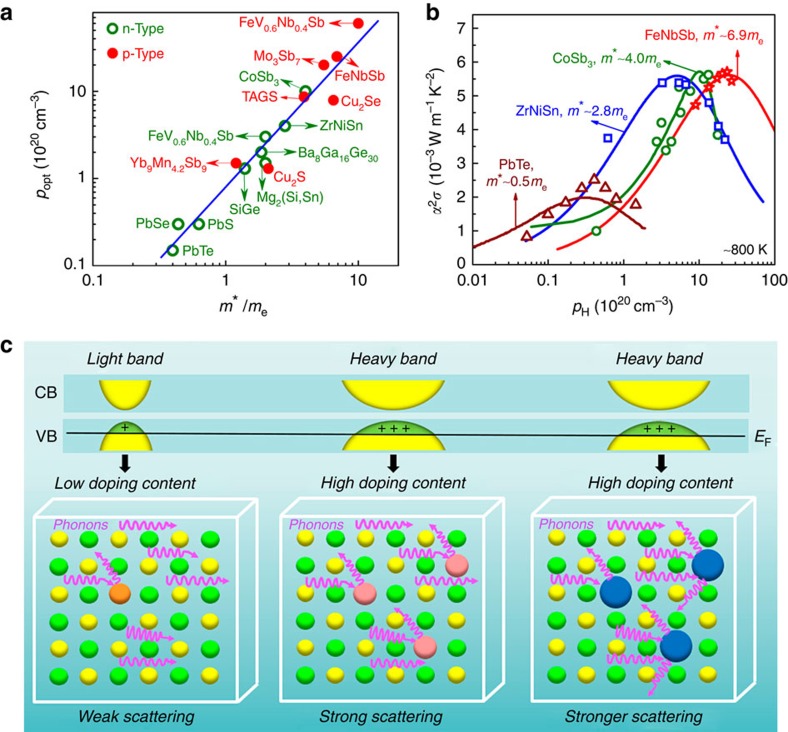
Comparison of transport character of light-band and heavy-band thermoelectric materials.(a) The optimal carrier concentration popt versus the density of state effective mass m* for thermoelectric materials1516273132333639404142434445. The solid line is a guide for eyes. (b) Carrier concentration dependence of power factor for the typical light-band PbTe15, and the heavy-band system: n-type ZrNiSn33, n-type filled CoSb346 and p-type FeNbSb near 800 K. (c) The schematic drawing shows the effect of band structure character on optimal doping content and hence phonon scattering.